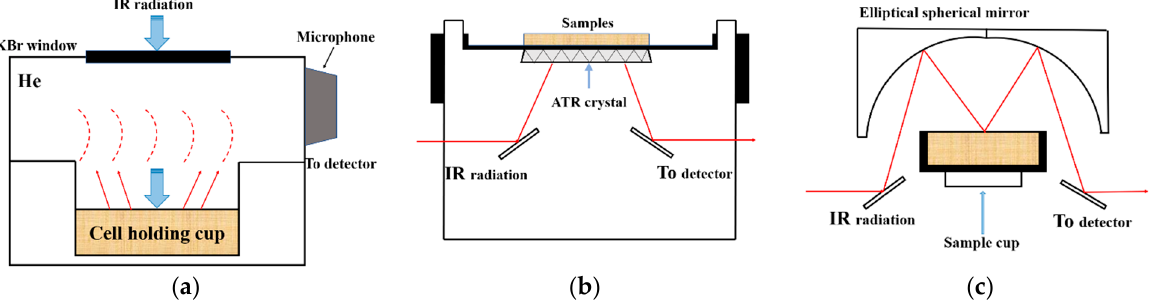
Figure 1. Schematic diagram of light path of ( a ) Fourier transform infrared photoacoustic spectroscopy (FTIR-PAS), ( b ) Fourier transform infrared attenuated total reflectance spectroscopy (FTIR-ATR), and ( c ) diffuse reflectance Fourier transform infrared spectroscopy (DRIFTS).